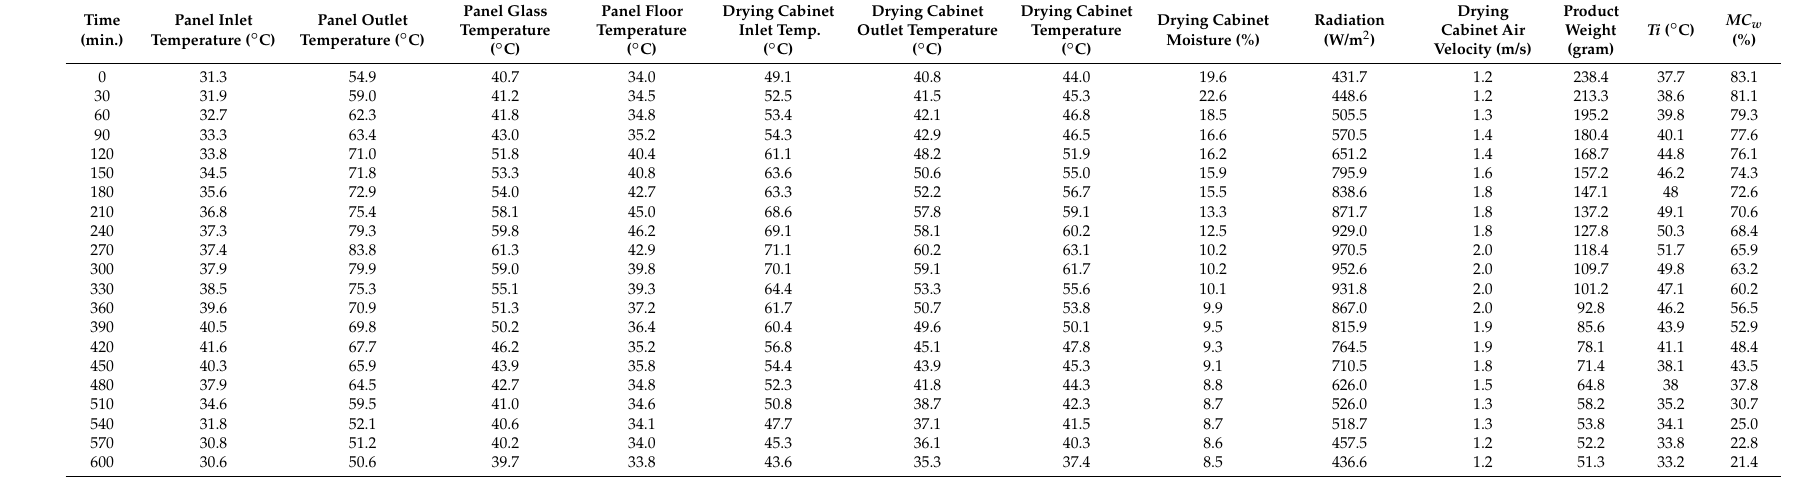
Table 3. Air heated solar collector (AHSC) drying system experiment